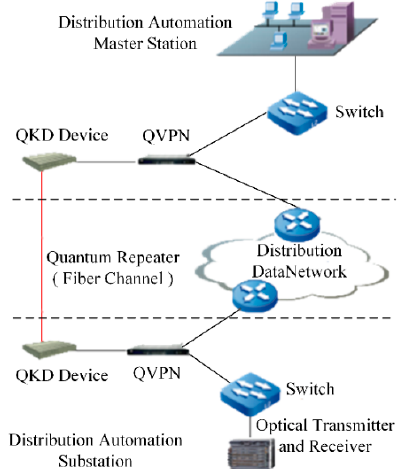
Figure 7. Distribution automation architecture based on QKD.